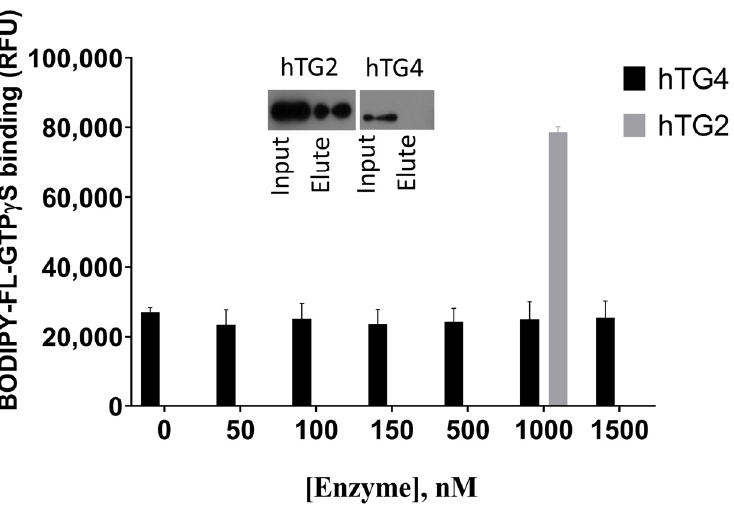
Figure 4. Human TG4 does not bind BODIPY-GTP γ S or GTP. Increasing concentrations of hTG4 (50, 100, 150, 500, 1000 or 1500 nM) were incubated with 500 nM BODIPY-GTP γ S for 5 min, and then the fluorescence intensity was measured (Ex/Em: 485/520 nm). Data are presented as means with ± SD from two separate experiments done in triplicates. As a positive control, 1000 nM hTG2 was applied, resulting in 78,629 ± 1531,60 RFU. The inlet shows the binding property of hTG2 and hTG4 to GTP-agarose resin. Representative picture of Western blots after SDS-PAGE from two independent experiments using monoclonal anti-polyHis/HRP antibody.